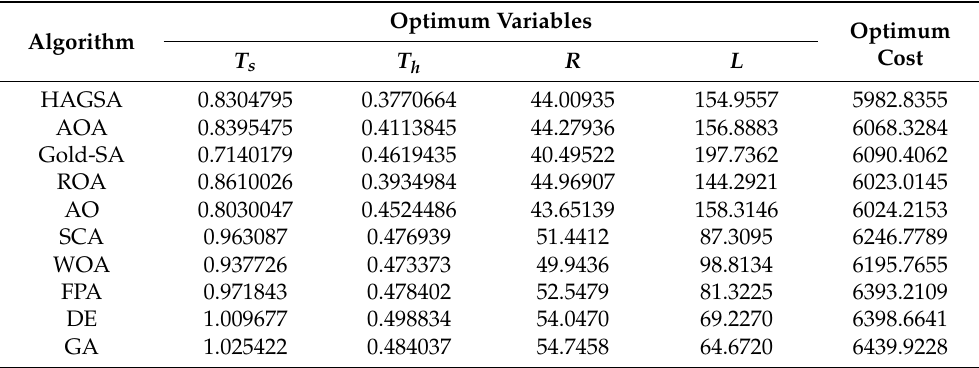
Table 7. Statistical results of the pressure vessel design